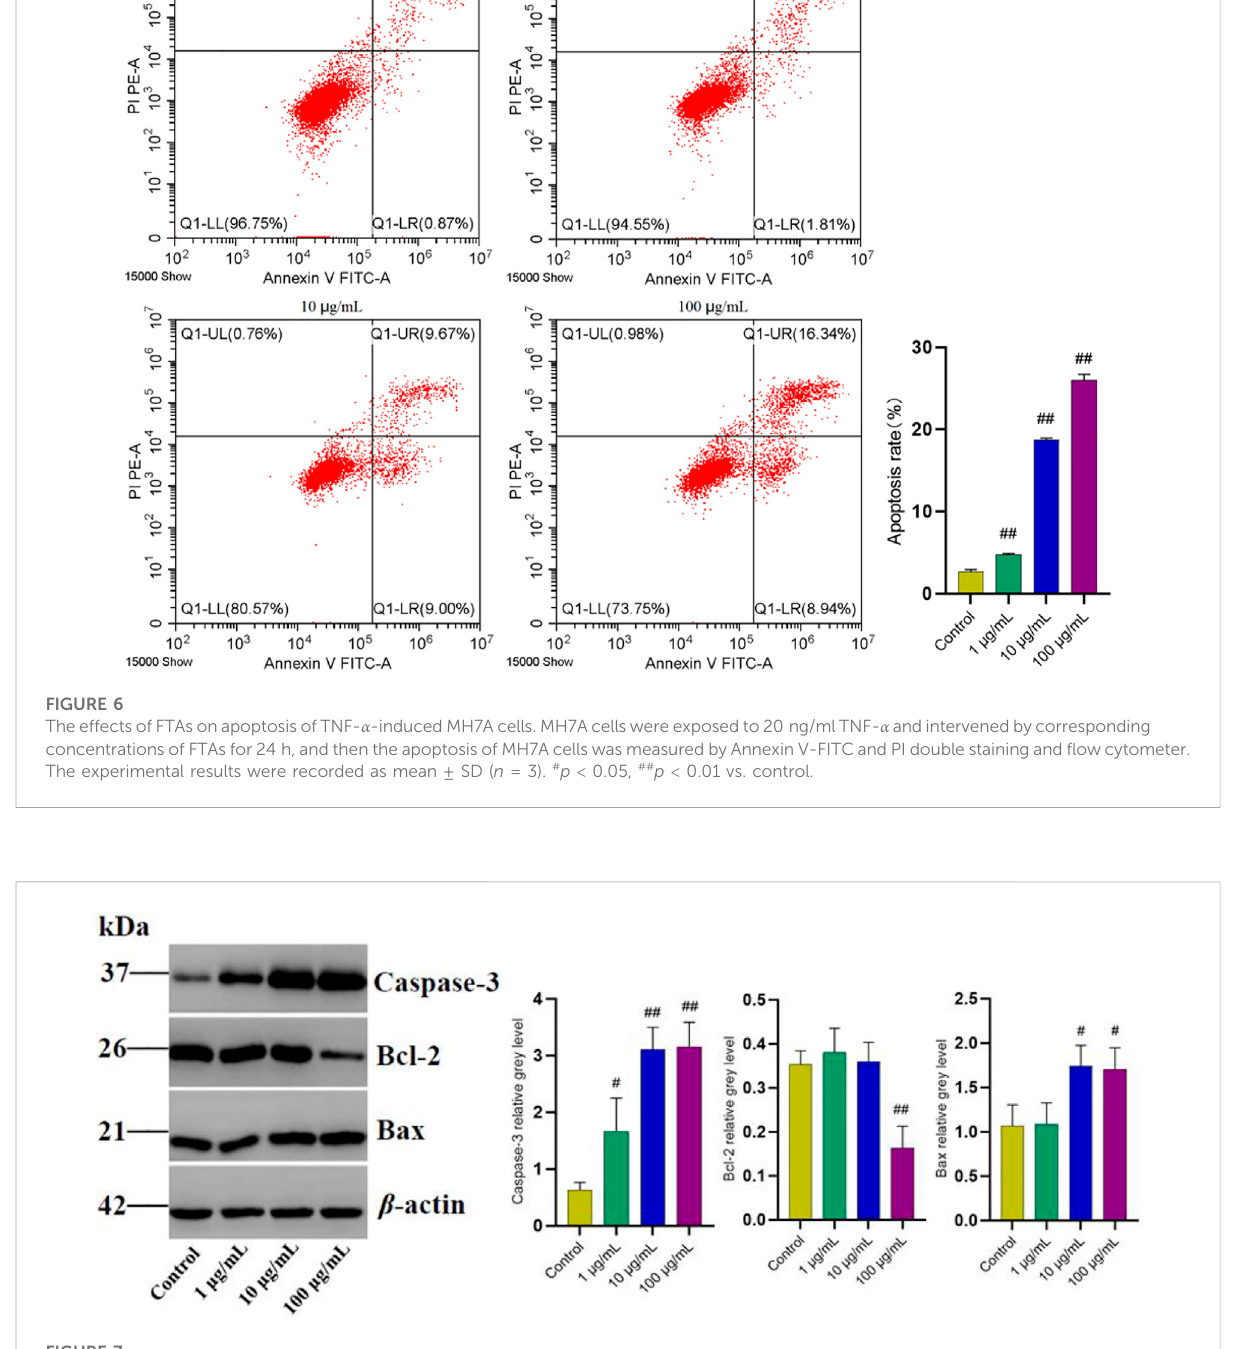
The effects of FTAs on mitochondrial apoptosis signaling pathway in TNF- α -induced MH7A cells. MH7A cells were exposed to 20 ng/ml TNF- α and intervened by corresponding concentrations of FTAs for 24 h, and then the protein signal intensity of caspase-3, Bcl-2 and Bax were measured by western blot. The experimental results were recorded as mean ± SD ( n = 3). # p < 0.05, ## p < 0.01 vs.